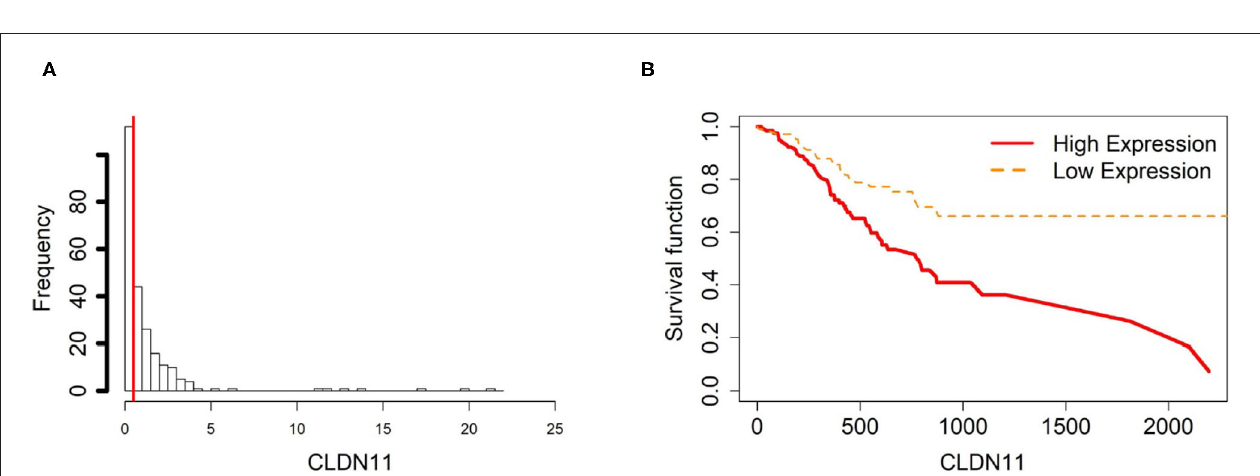
FIGURE 5 | Survival analysis in CLDN11. (A) Describes the histogram of CLDN11 gene expression. Based on the CLDN11 data extracted from TCGA-STAD, we set 0.5 as the gene expression threshold to separate the 238 observations into two groups: low expression and high expression groups of samples. (B) Shows the estimated survival function plots using a Cox proportional hazard regression analysis in CLDN11 between the two groups; FDR p -value = 0.0325 indicates a significant survival time difference between the two groups.